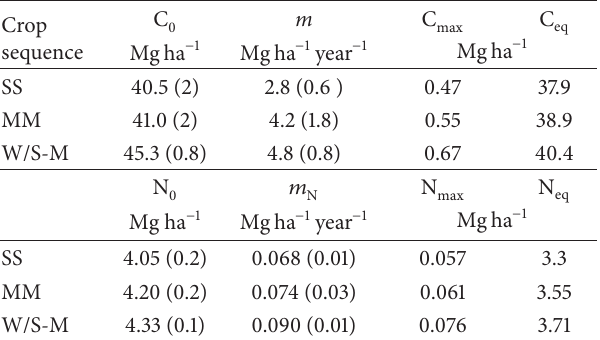
Table 6: Measured C (N max ), and C eq (N eq ) at